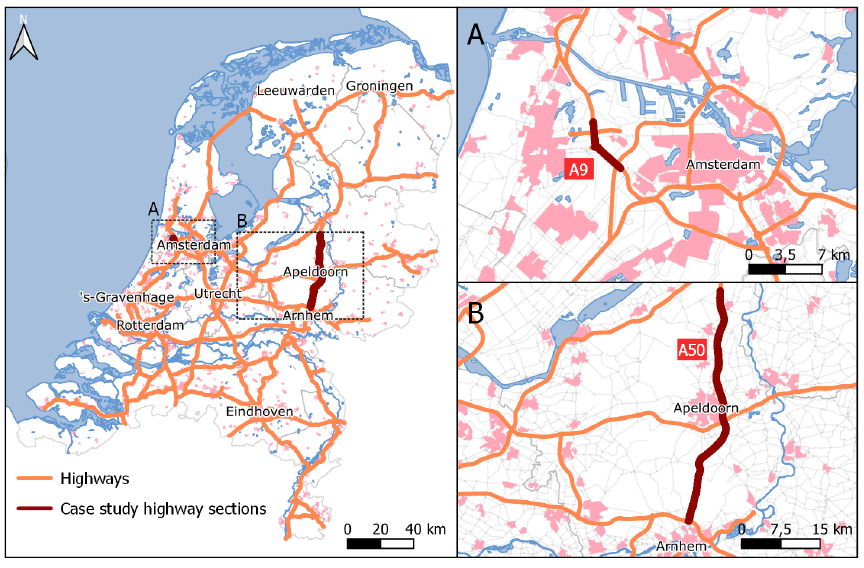
Figure 7. Overview of the selected sections for the case study.